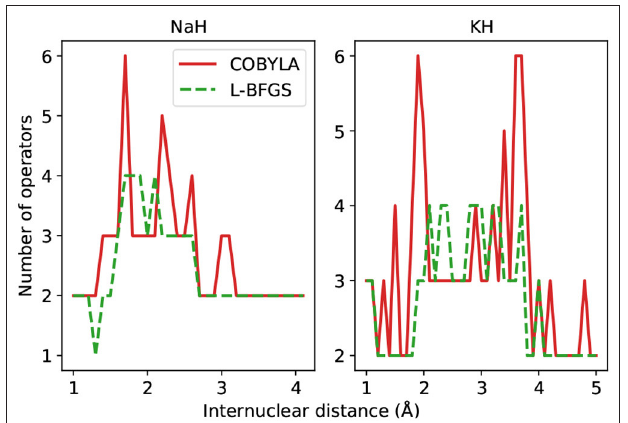
FIGURE 8 | Number of operators in the ADAPT-VQE ansatze using the COBYLA (solid line) and L-BFGS (dashed line) optimizers. The corresponding VQE ansatz has two operators.